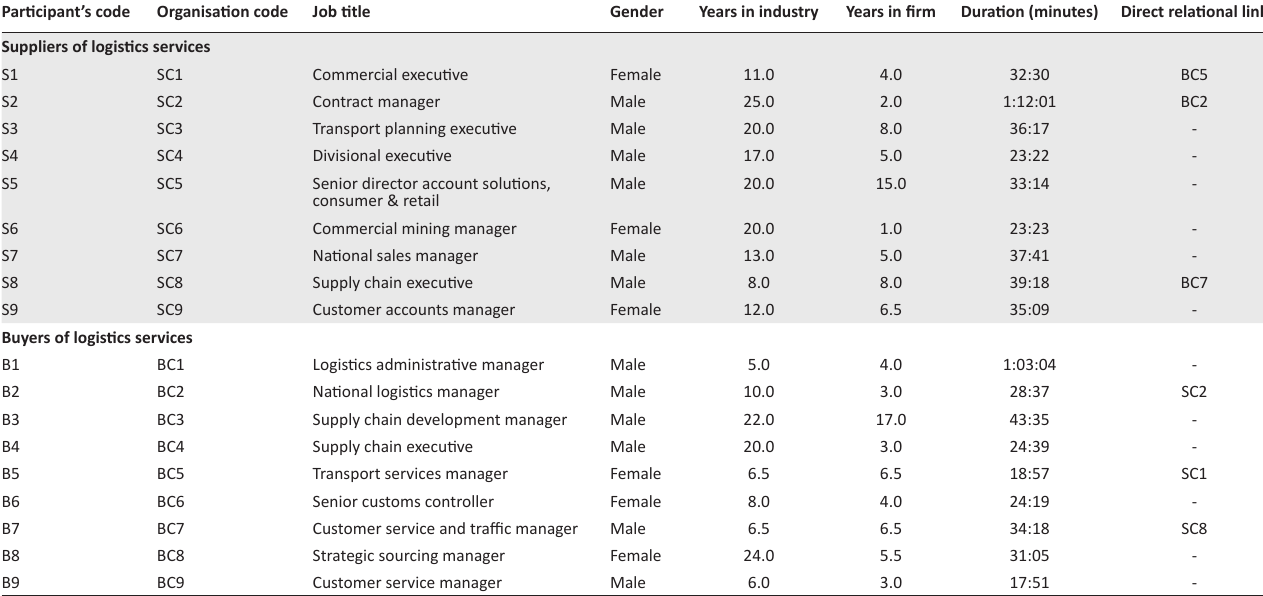
TABLE 4: Description of the participants’ profiles. Participant’s code Organisation code Job